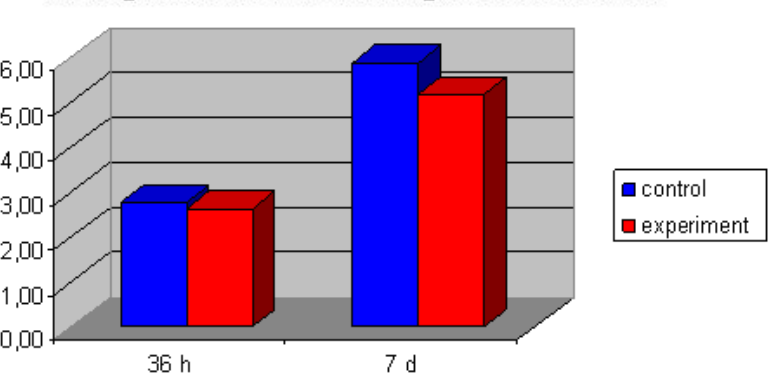
FIGURE 1 – Average number of mitosis figures at both times